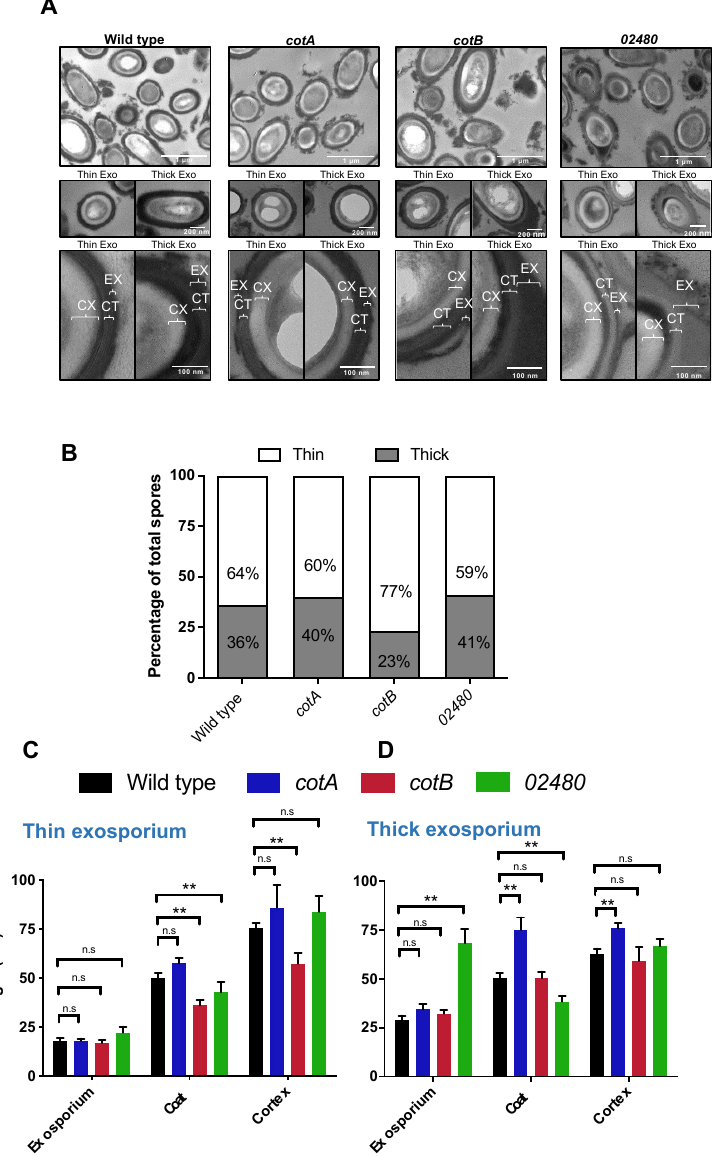
Figure 2. Effect of absence of spore coat proteins in the ultrastructure of C. difficile spore ( A ). Thin sections of C. difficile 630 ∆ ermB and coat mutant derivatives (cotA::CT555a , cotB cotB::CT329a and CDIF630_02480::CT60a ) spores were analyzed via transmission electron microscopy, as described in